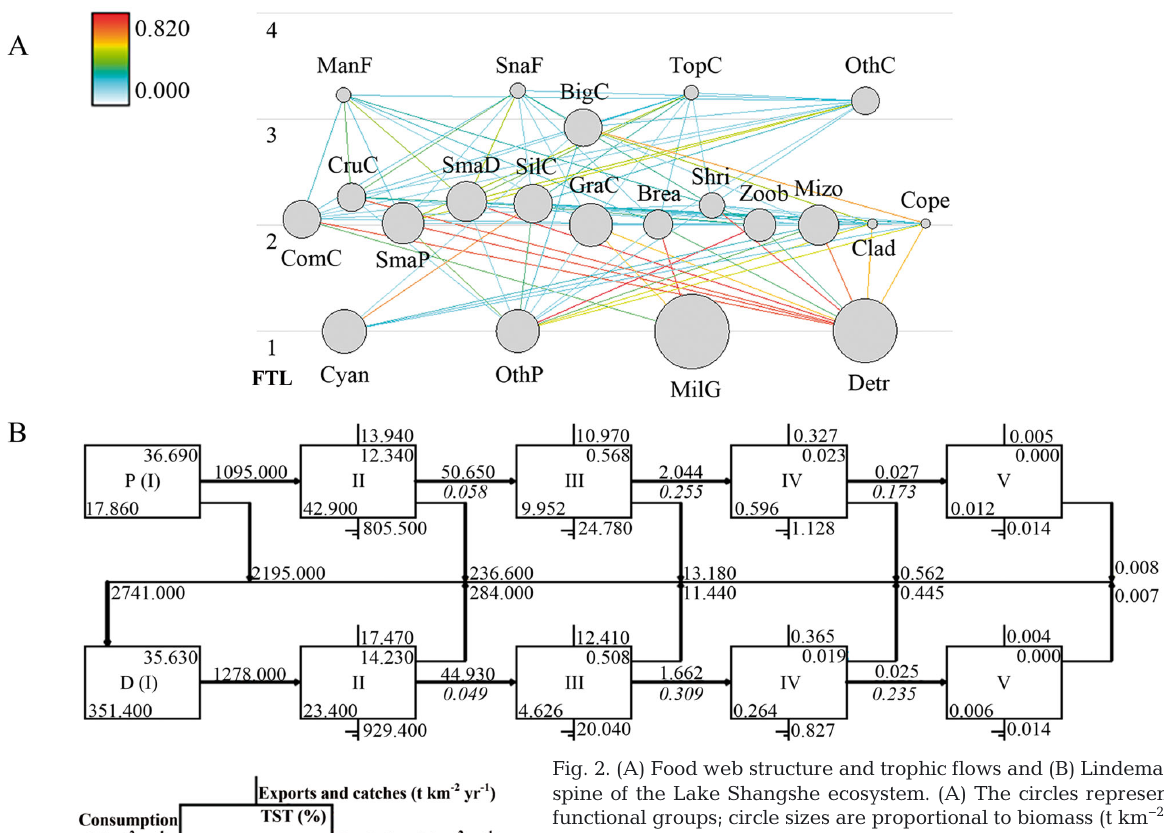
Fig. 2. (A) Food web structure and trophic flows and (B) Lindeman spine of the Lake Shangshe ecosystem. (A) The circles represent functional groups; circle sizes are proportional to biomass (t km −2 ); lines reflect trophic flows; color key (dimensionless) represents the proportion that the prey contributed to a predator’s diet; FTL: frac- tional trophic level; group abbreviations as in Table 3. (B) P: primary producers; D: detritus; I to V: aggregated trophic levels (ATLs); TE: transfer efficiency; TST: total system throughput; exports and catches: harvest of cultured